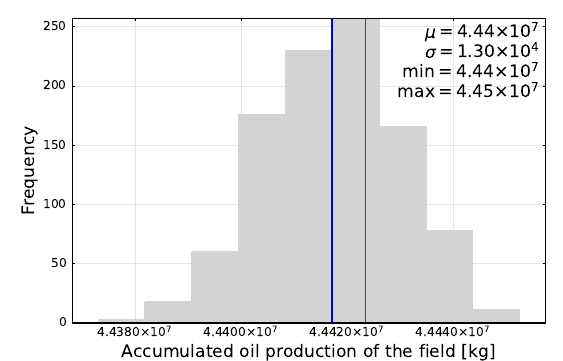
Figure 9: Posterior model uncertainty. NOTE the